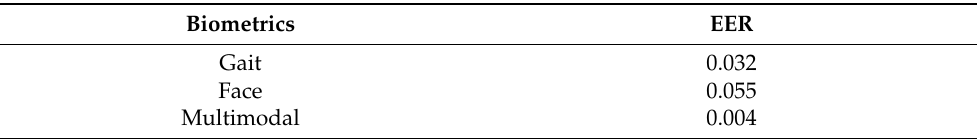
Table 9. Equal error rates for the proposed biometric recognitions